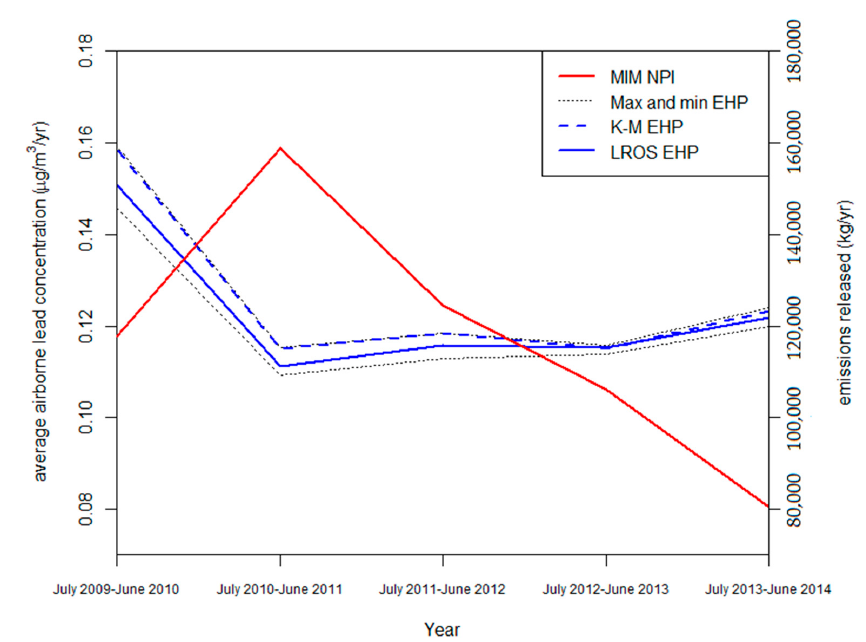
Figure 1. Comparison of annually averaged lead concentration using various analysis techniques calculated from Environment and Heritage Protection (EHP) data and The National Pollutant Inventory (NPI) annual emission estimates.